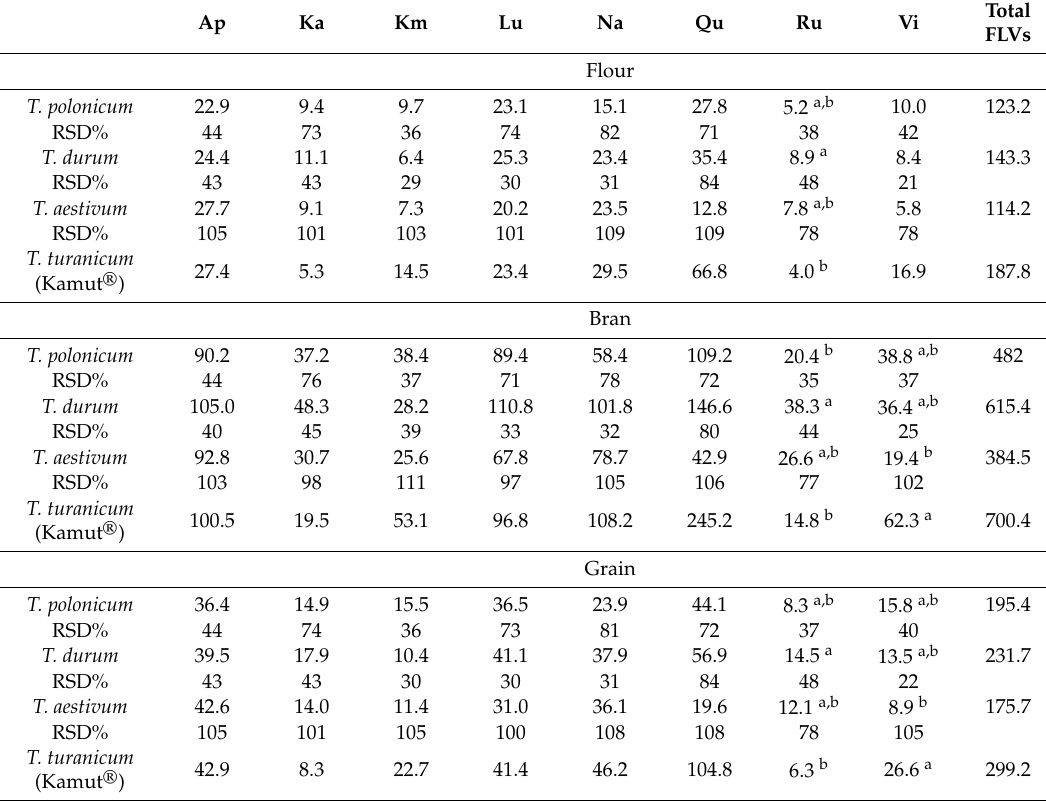
Table 4. Concentrations of the analyzed flavonoids (mg kg − 1 ) in the flour, bran, and grain of T. polonicum versus four T. durum cultivars, four T. aestivum cultivars, and Kamut ® wheat. Ap Ka Km Lu Na Qu Ru Vi